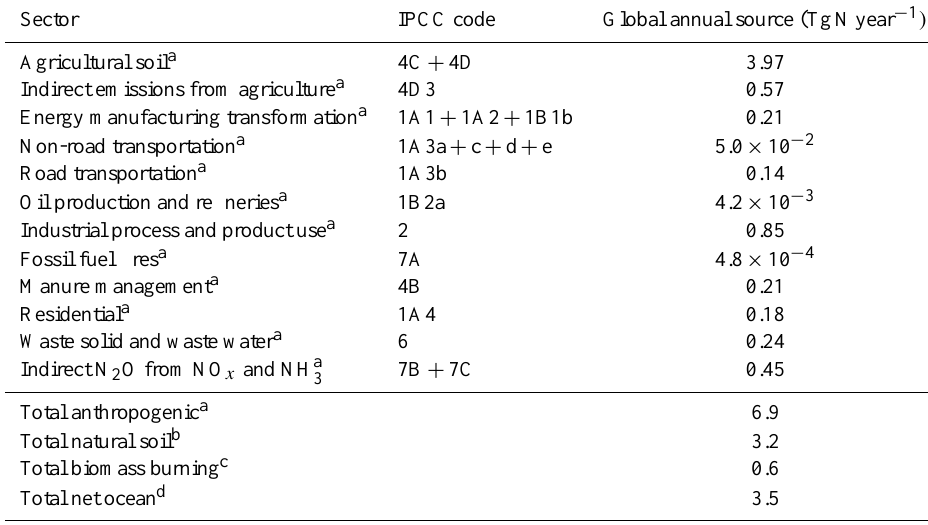
Table 1. N 2 O emissions in the a priori database and their global annual